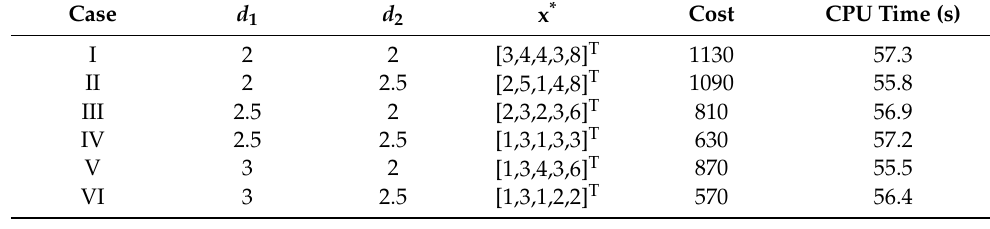
Table 4. The superior design * x , cost, and CPU times of six cases.